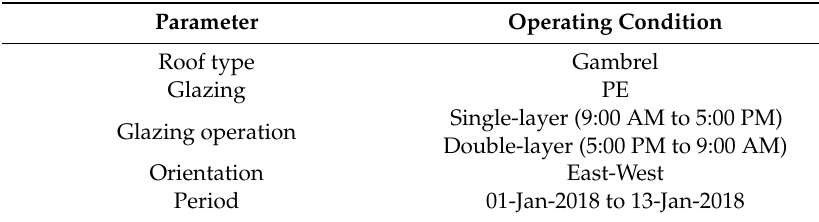
Table 6. Summary of reference greenhouse with temperature-controlled vents and heating